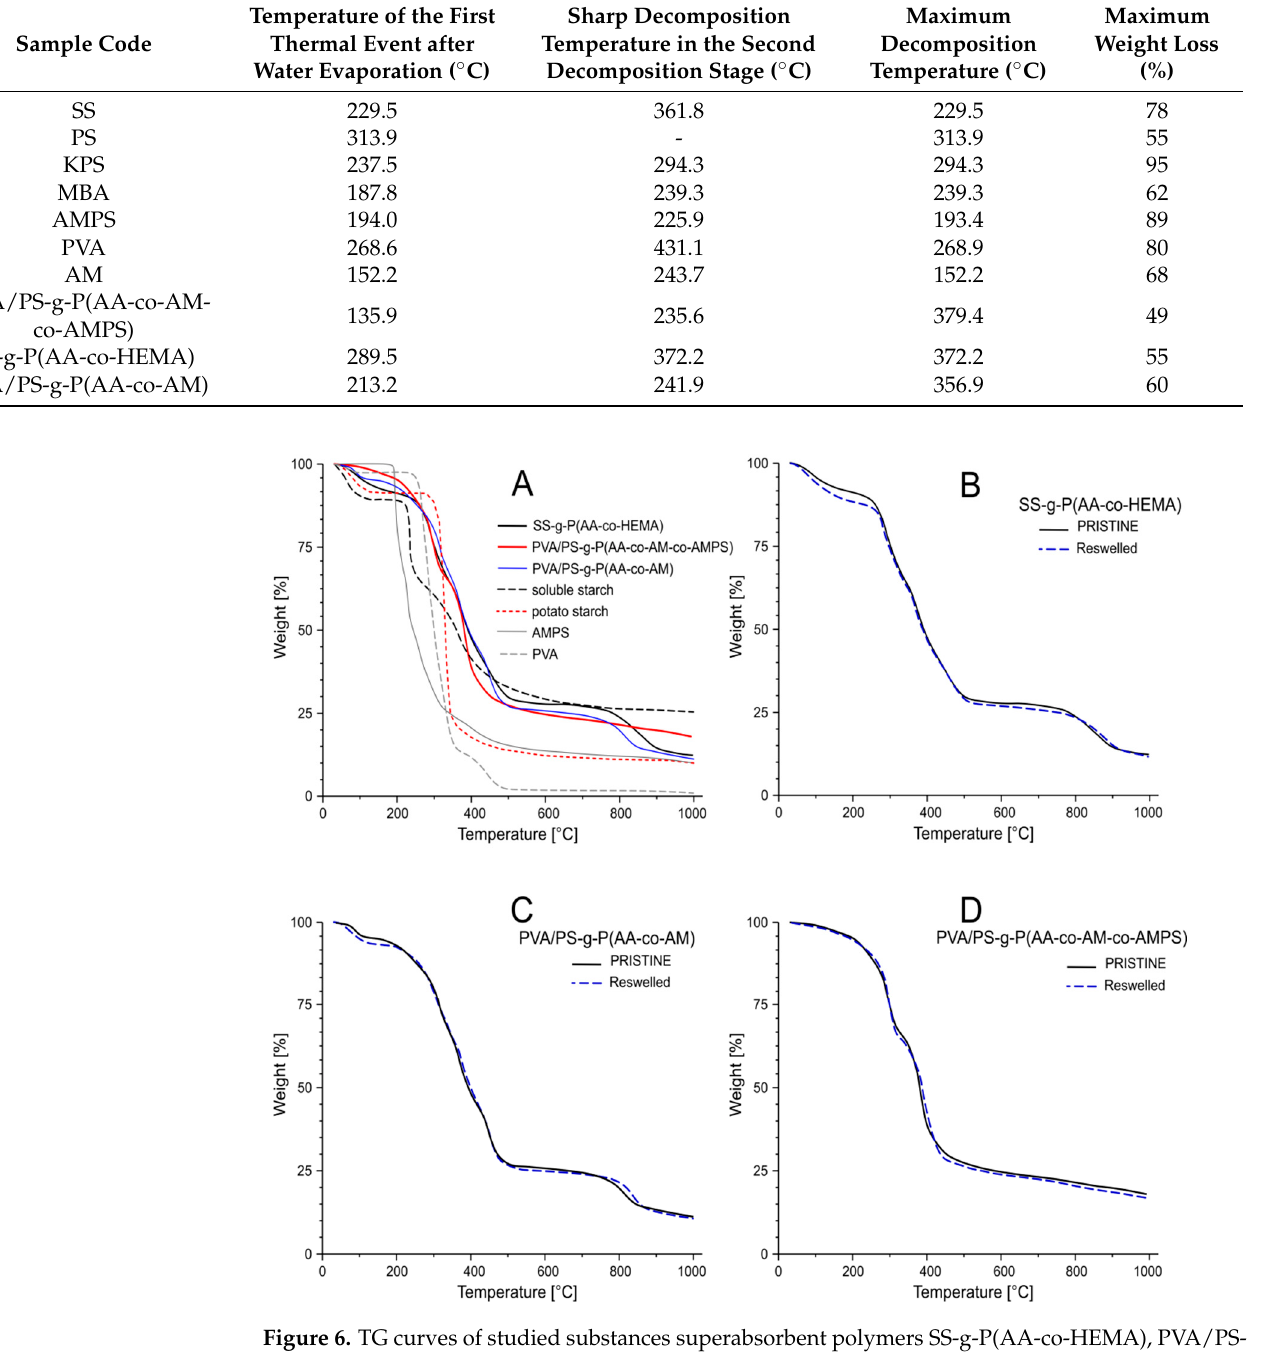
Table 2. TG data for monomers and superabsorbent polymers.